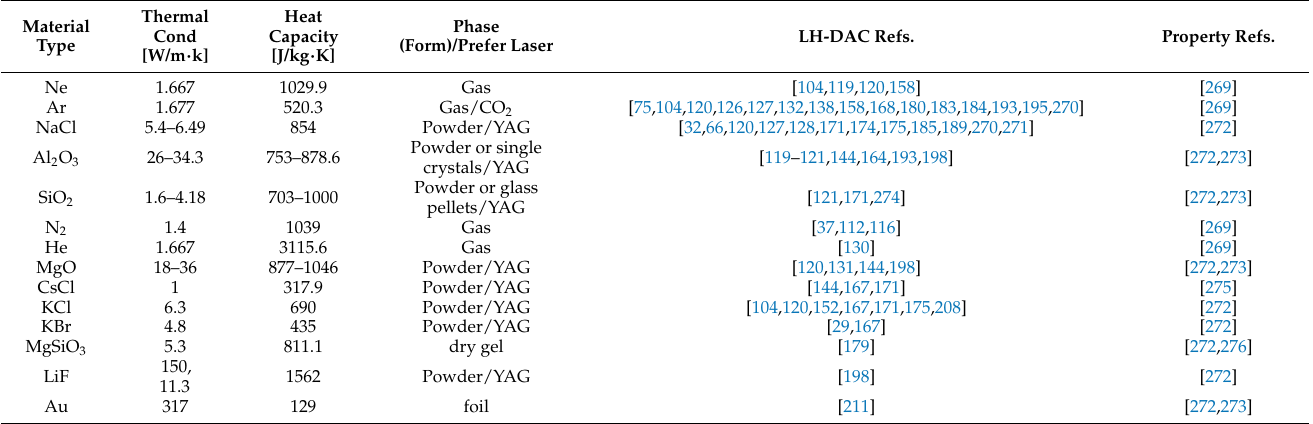
Table 1. Physical properties of common LH-DAC pressure media, including compressive strengths, thermal conductivities, and absorption coefficients at ambient conditions, 300 ± 100 K.